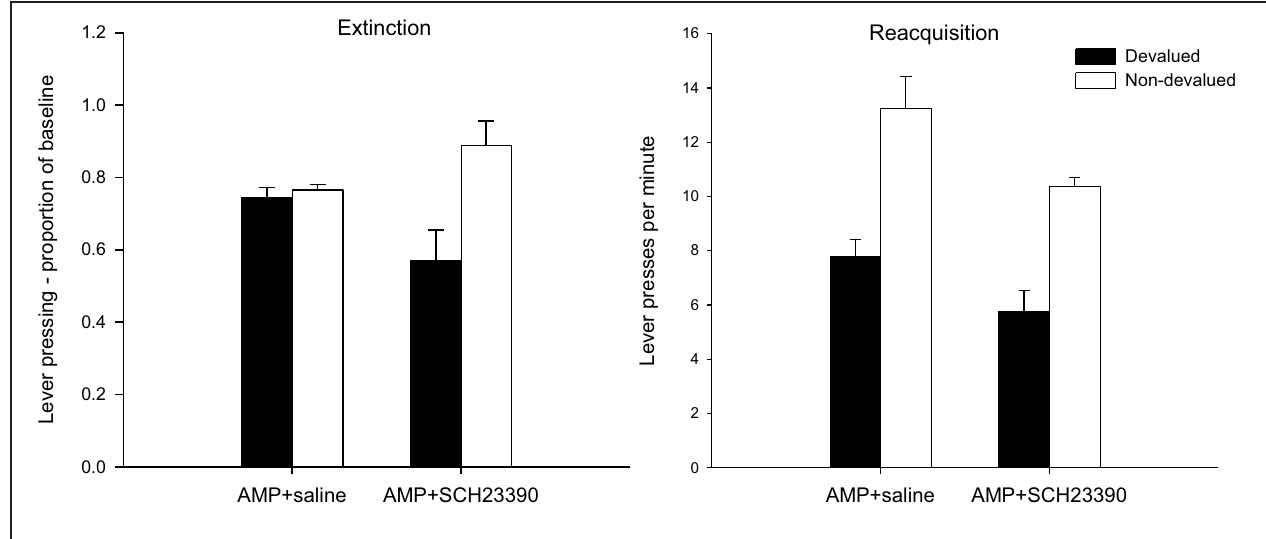
FIGURE 2 | Effect of SCH23390 following amphetamine sensitization on sensitivity of lever pressing to reward devaluation by LiCl-induced nausea. Mean lever presses per minute as a proportion of baseline ( ± SEM)